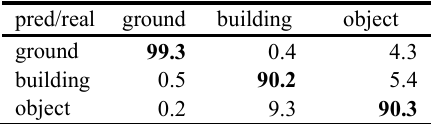
Table 3: Confusion matrix (% recall ) for 3 classes, 200 hidden layers and weighted.